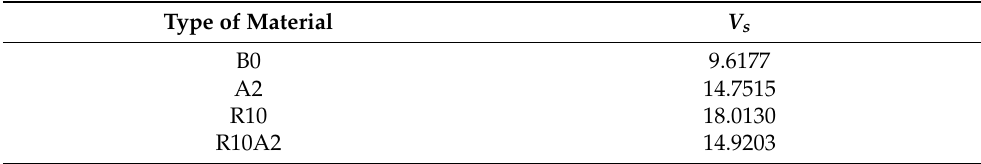
Table 6. Values of the coefficient of variation V s for the tested